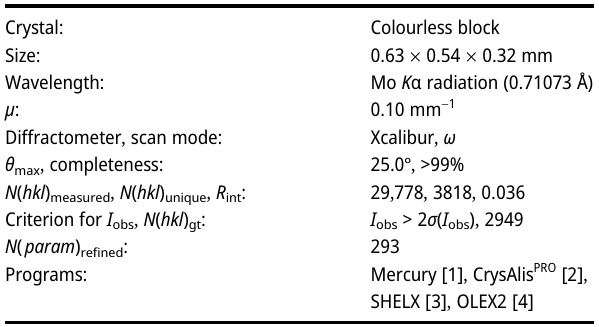
Table  : Data collection and